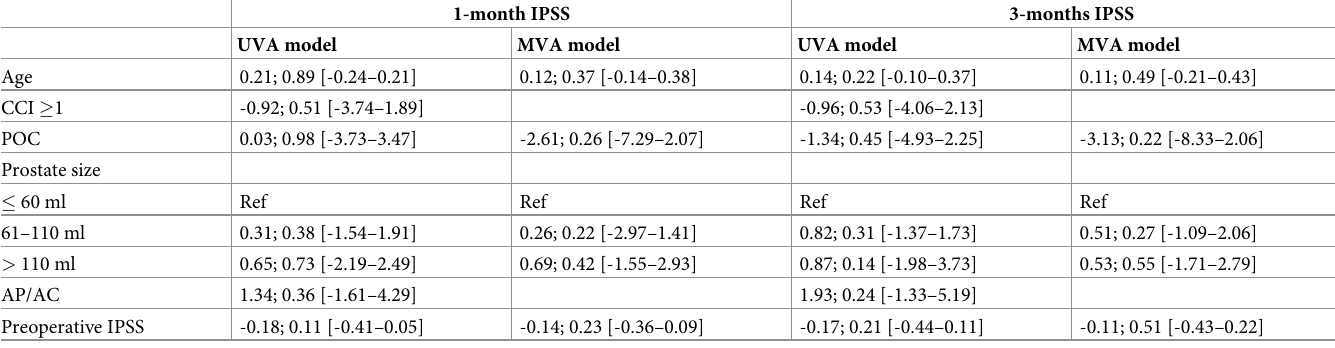
Table 4. Univariable and multivariable linear regression models (beta; p value [95%CI]) predicting IPSS at 1 and 3 months after